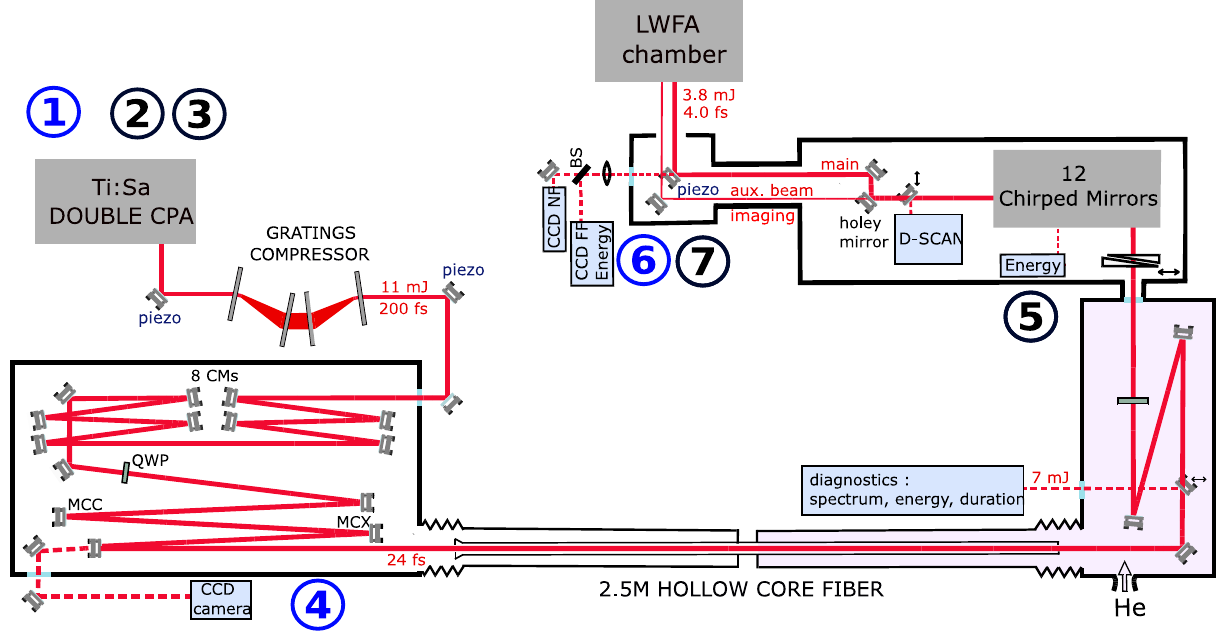
FIG. 2. Schematic of the laser system. Numbers ① , ④ , ⑥ show the position of the beam pointing stabilization devices, numbers ② , ③ , ⑤ , ⑦ correspond to the position of energy diagnostics for the booster amplifier, the power amplifier, the hollow core fiber (HCF) compressor and the turning box,